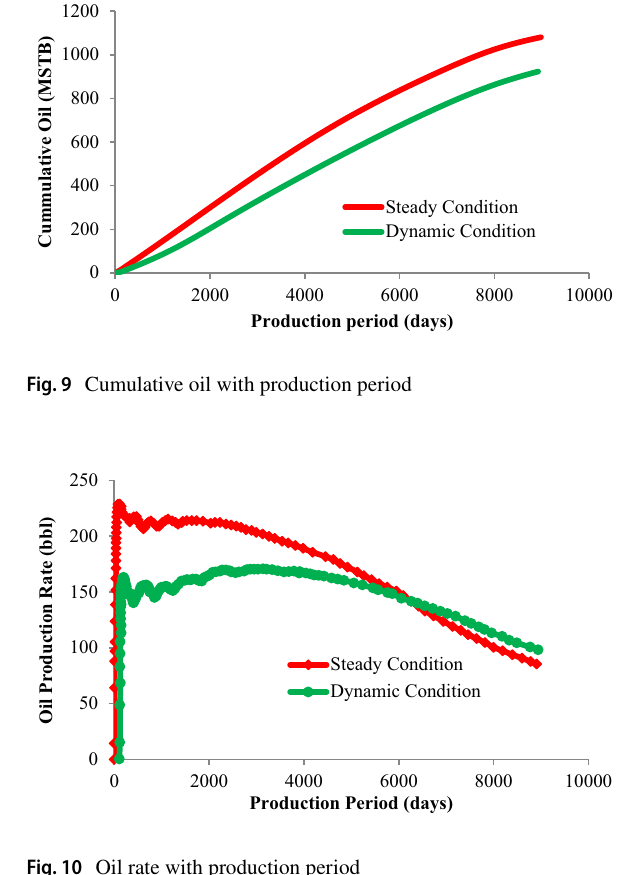
Fig. 10 Oil rate with production period